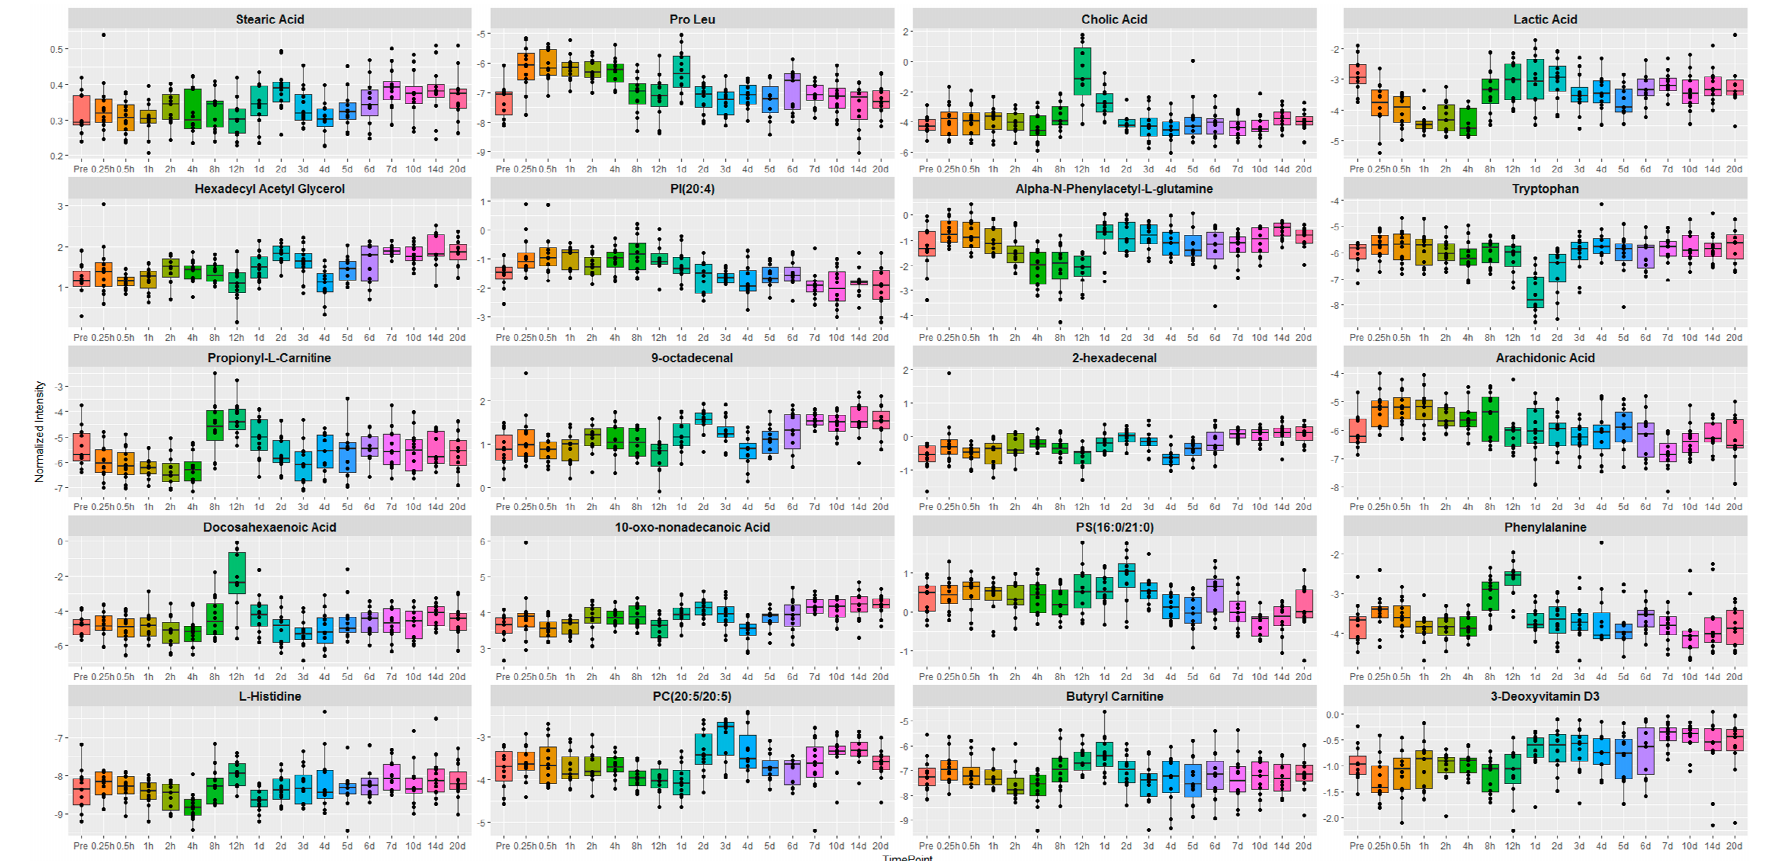
Figure 3. Representative box and whisker plots. Visualization of top 20 biomarkers as box and whisker plots with log transformed normalized intensity along Y -axis and time point on X -axis. Most biomarkers showed moderate changes in the 12 h to 3 day time points, with stabilization occurring from day 3 onward.